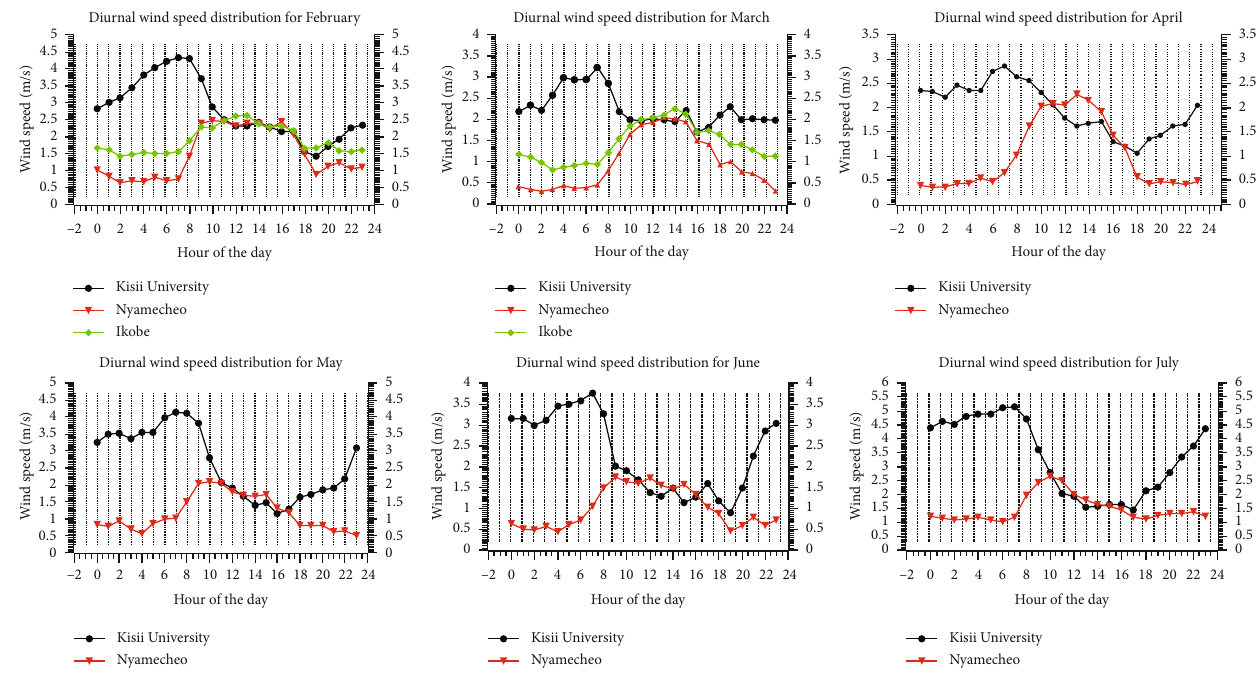
Figure 3: Diurnal wind speed distribution pattern for six